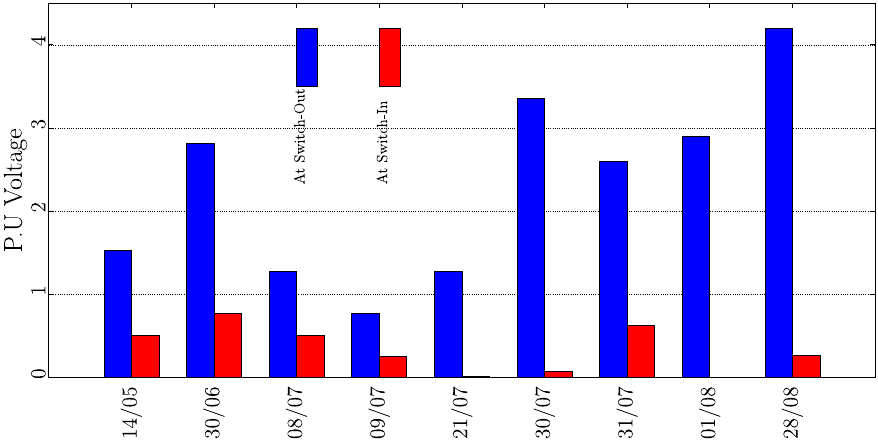
Figure 9. Derived p.u voltages for all tests, calculated using the sensitivity recorded during AC calibration.